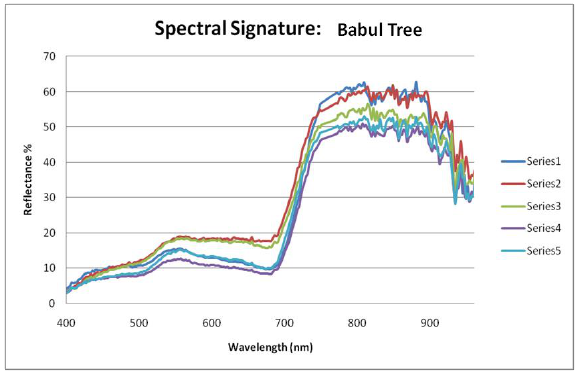
Fig.14. Spectral Signature of Babul Trees.